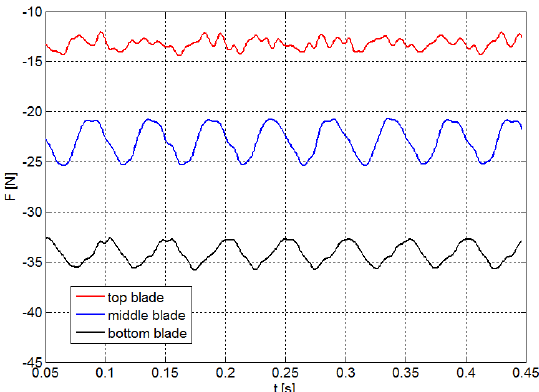
Fig. 1. Test geometric configuration of the simplified cascade which consists of three oscillating flat plates. The dimensions are in millimetres. The width of the plates is 0.08m. Fig. 4. Pressure contours at time t = 0 . 0433s, where the middle plate has a zero displacement.